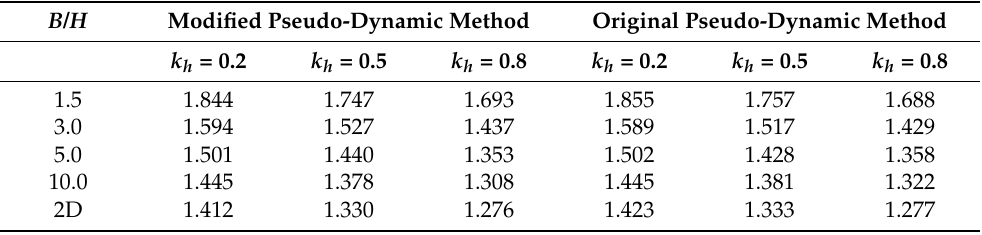
Table 2. Comparisons between the modified pseudo-dynamic solutions and the original pseudo- dynamic solutions, corresponding to H = 15 m, β 1 = β 2 = 45 ◦ , λ a = 0.0, m = 1.6, c 0 = 25 kPa, σ t = 30 kPa, T = 0.1 s, V s = ∞ .